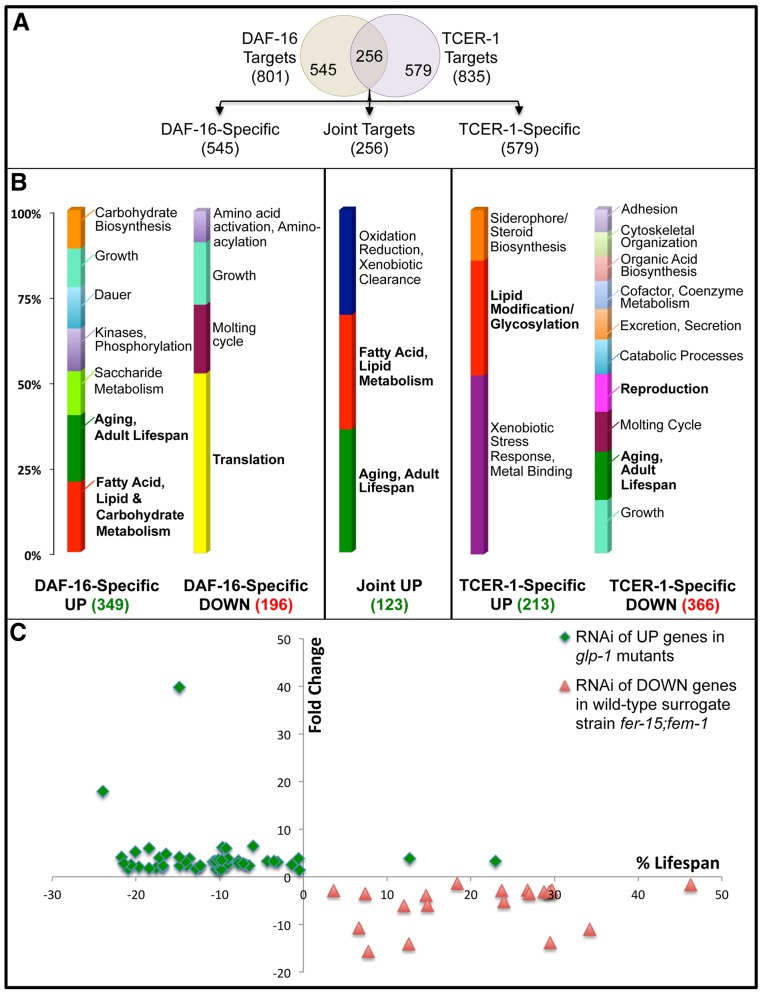
Identification of genes up regulated and downregulated by DAF-16 and TCER-1 following germline loss, and effects of their knockdown on lifespans of glp-1 mutants and wild-type worms, respectively.A. Comparison of the transcriptomes of glp-1, daf-16;glp-1 and tcer-1;glp-1 day 2 adult mutants by RNA-Seq identified 685 genes whose expression is increased in glp-1 mutants (UP genes) by DAF-16 and/or TCER-1 (349 DAF-16-Specific UP targets, 213 TCER-1-Specific UP targets and 123 Joint UP targets) and 635 genes whose expression was repressed (DOWN genes: 196 DAF-16-Specific, 366 TCER-1-Specific and 73 Joint). B: DAVID analysis of DAF-16 and TCER-1 targets. The three UP groups (green) share an enrichment of lipid-metabolic genes (labeled in bold). Aging and lifespan regulation is another notable category enriched in DAF-16-Specific and Joint UP groups. The major GO category enriched in DAF-16-Specific DOWN group was translation (bold), whereas, growth, reproduction and aging were highly enriched in the TCER-1-Specific DOWN class. C: RNAi knockdown of UP and DOWN genes shortens glp-1 longevity and increases the lifespan of a wild-type surrogate strain fer-15;fem-1, respectively. The scatter-plot represents the combined results from knockdown of UP and DOWN genes. UP genes were inactivated by initiating RNAi from day 1 of adulthood in glp-1 mutants (green diamonds). The red triangles represent RNAi inactivation of TCER-1-Specific DOWN genes, from day 1 of adulthood, in the strain fer-15;fem-1 that has been used extensively as a surrogate for wild-type worms [16, 17]. The X-Axis depicts the fold-change in gene expression detected by RNA-Seq for each of the genes. The Y-Axis represents the percent effect on lifespan as compared to the strains grown on empty vector control. Data shown here is from experiments of Trial #1 in S3 and S8 Tables, and do not include joint DAF-16/TCER-1 targets (as they have two different fold-change values). See S3 and S8 Tables for detailed lifespan data.